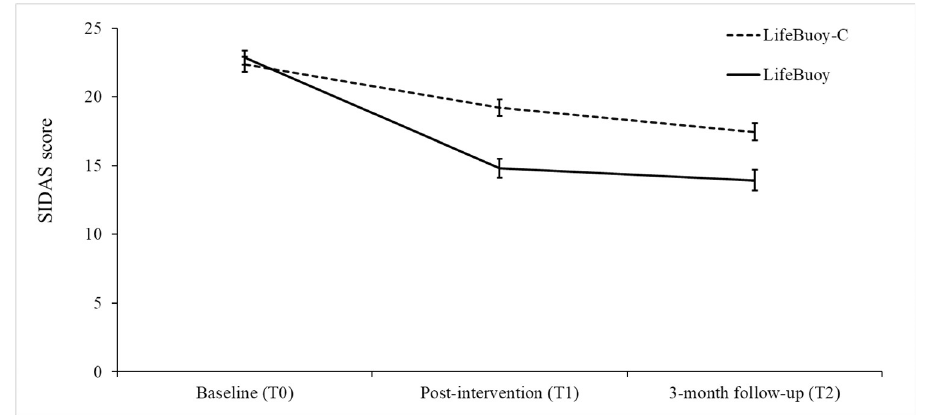
Fig 2. Comparison of SIDAS modeled mean scores at T0, T1, and T2. SIDAS, Suicidal Ideation Attributes Scale; T0, baseline; T1, postintervention; T2, 3-month postintervention.